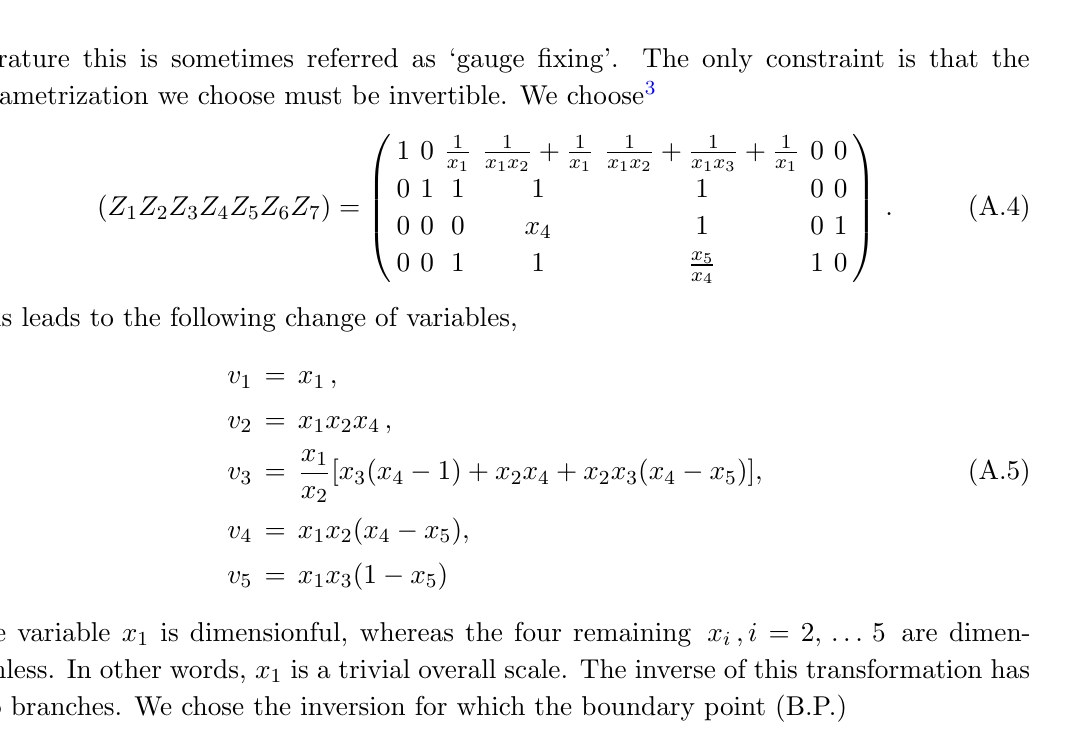
Figure 6 . Momentum twistor geometry of (a) (cid:12)ve-particle non dual-conformal scattering ampli- tudes (5 + 2 twistors) and (b) seven-particle scattering with dual conformal